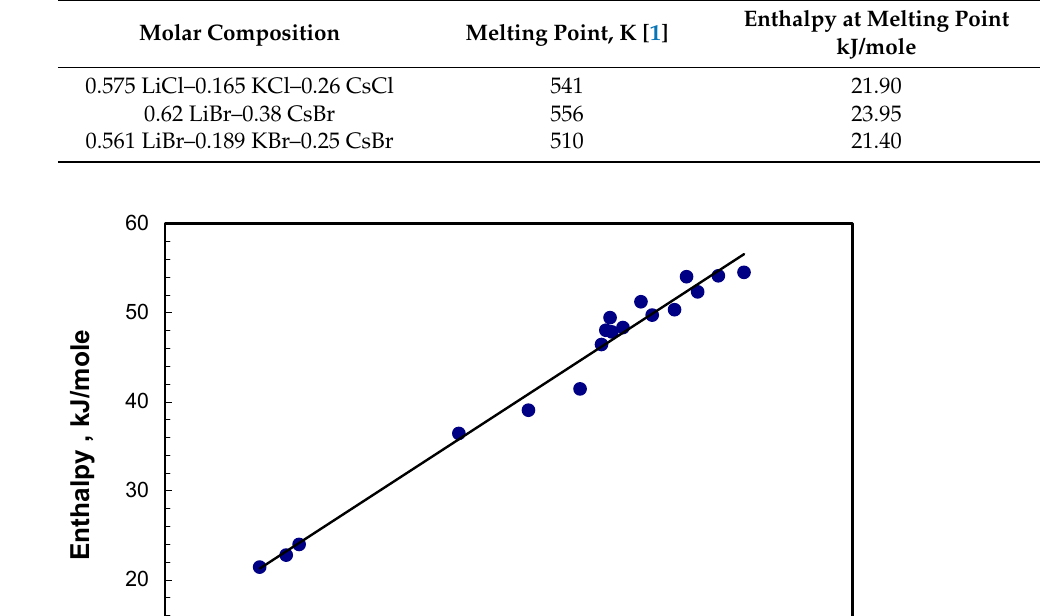
—our data, line—values (cid:35) Enthalpy at Melting Point